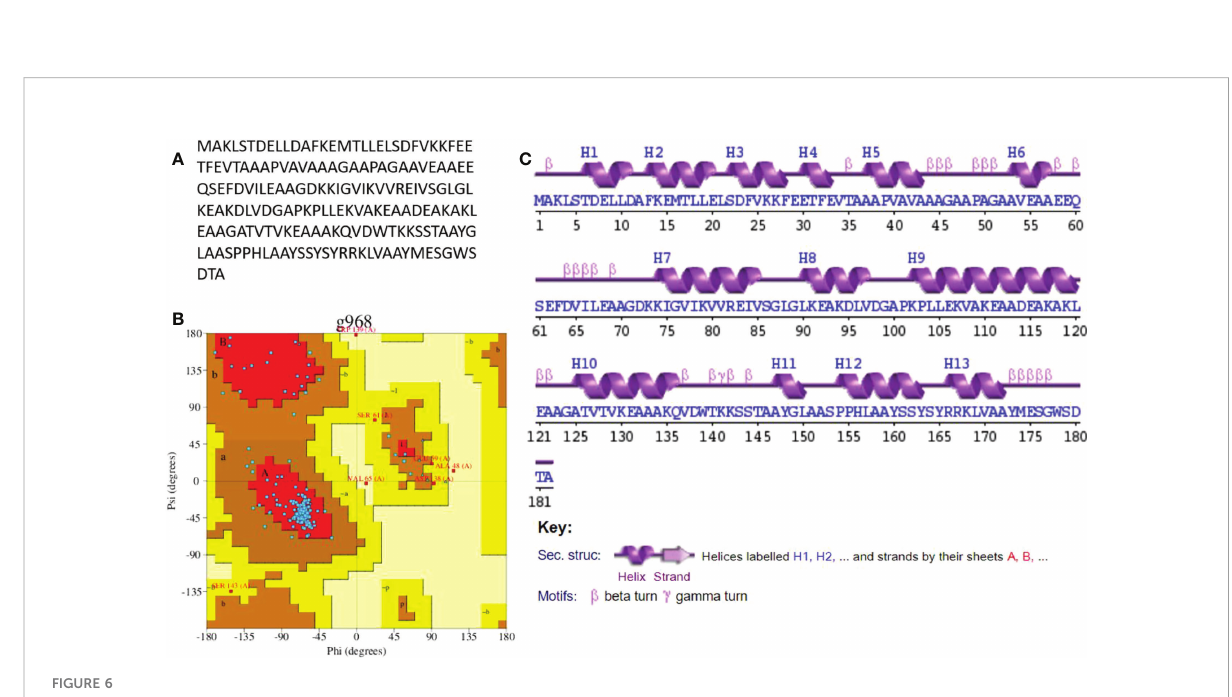
FIGURE 6 (A) Vaccine construct sequence (B) Ramachandran plot (C) secondary structure.